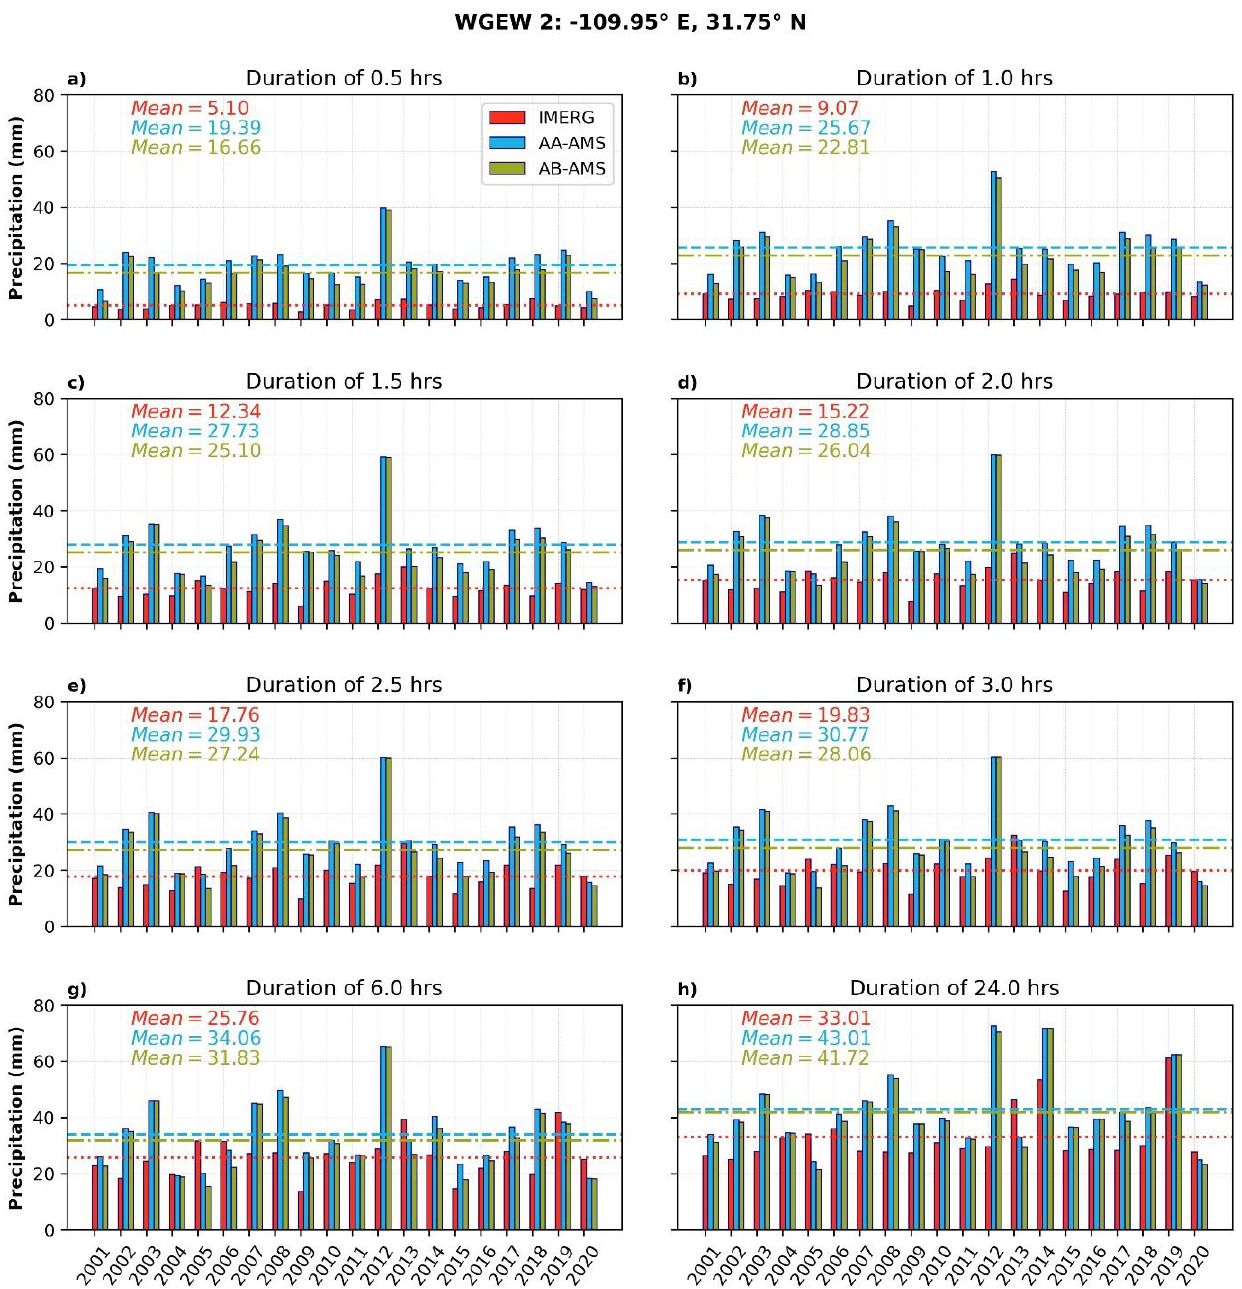
Figure A2. Annual maximum time series for WGEW 2 by durations. The subfigures illustrate event durations of 0.5-h ( a ), 1-h ( b ), 1.5-h ( c ), 2-h ( d ), 2.5-h ( e ), 3-h ( f ), 6-h ( g ), 24-h ( h ). In all the subfigures, thered bars are the IMERG AMS, the light blue bars are the AA-AMS, and the green bars are the AB-AMS. The dashed lines are the mean AMS for each case.